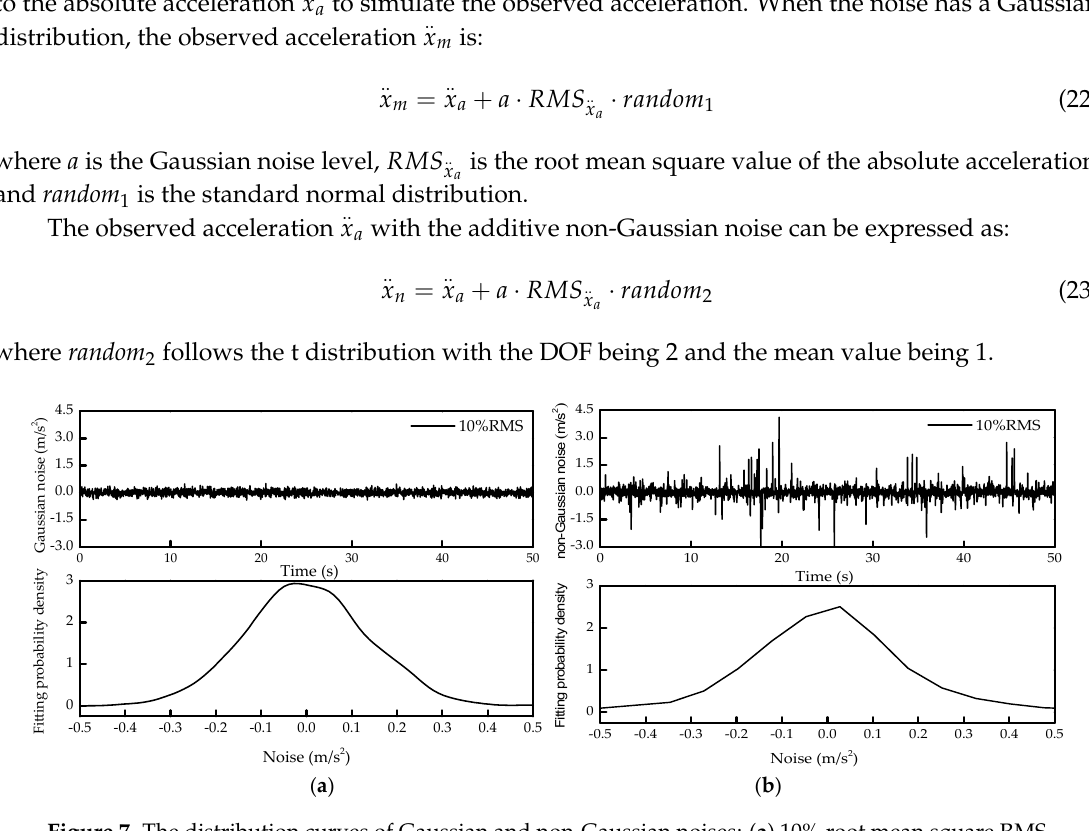
Figure 6. Relative damping errors by three integration methods.